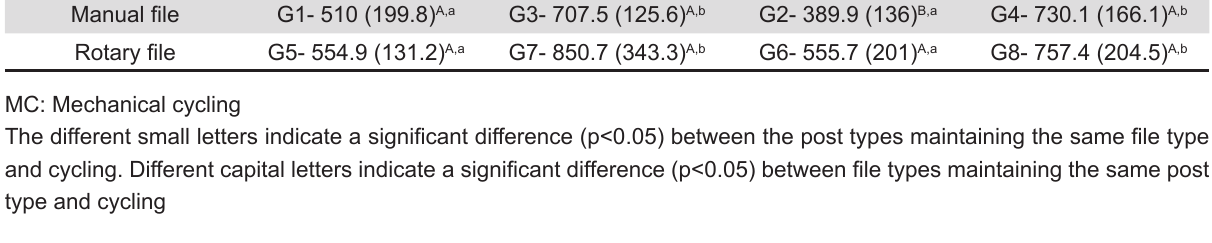
Table 2- Failure types numbers by t test between the post types maintaining the same endodontic file and mechanical